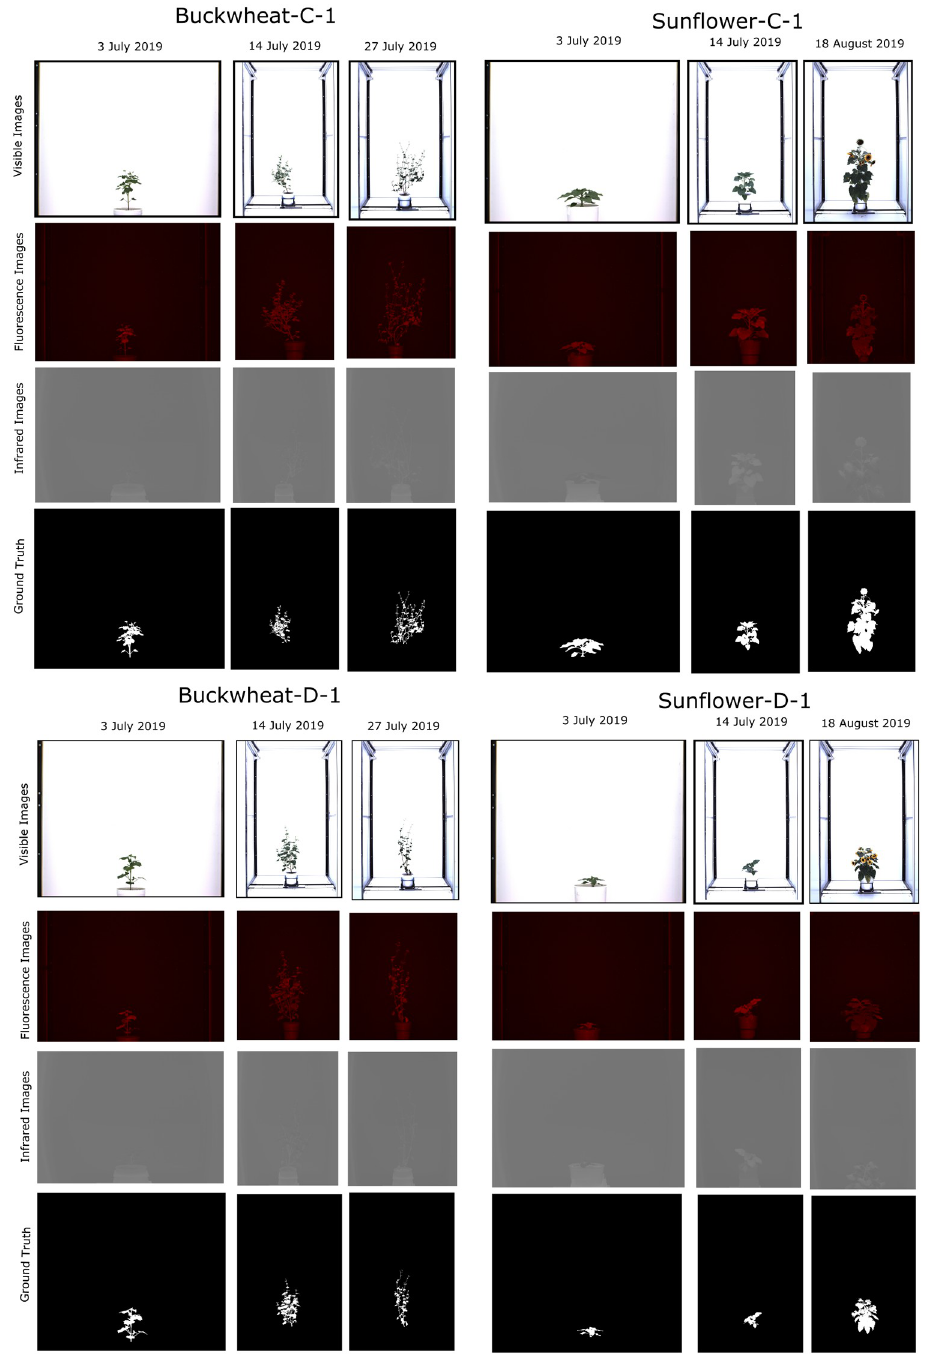
Fig 2. Preview of the proposed CosegPP . CosegPP is a data repository that contains four datasets: Buckwheat-C-1, Sunflower-C-1, Buckwheat-D-1, and Sunflower-D-1. The dataset names include the species name, C or D that represents Control or Drought induced, and a number representing the experimental repetition number. Each dataset includes visible, fluorescence, infrared, and ground truth images with 7 to 14 temporal images from 3 July to 18 August 2019. This preview shows only 3 temporal images in the 0-degree side